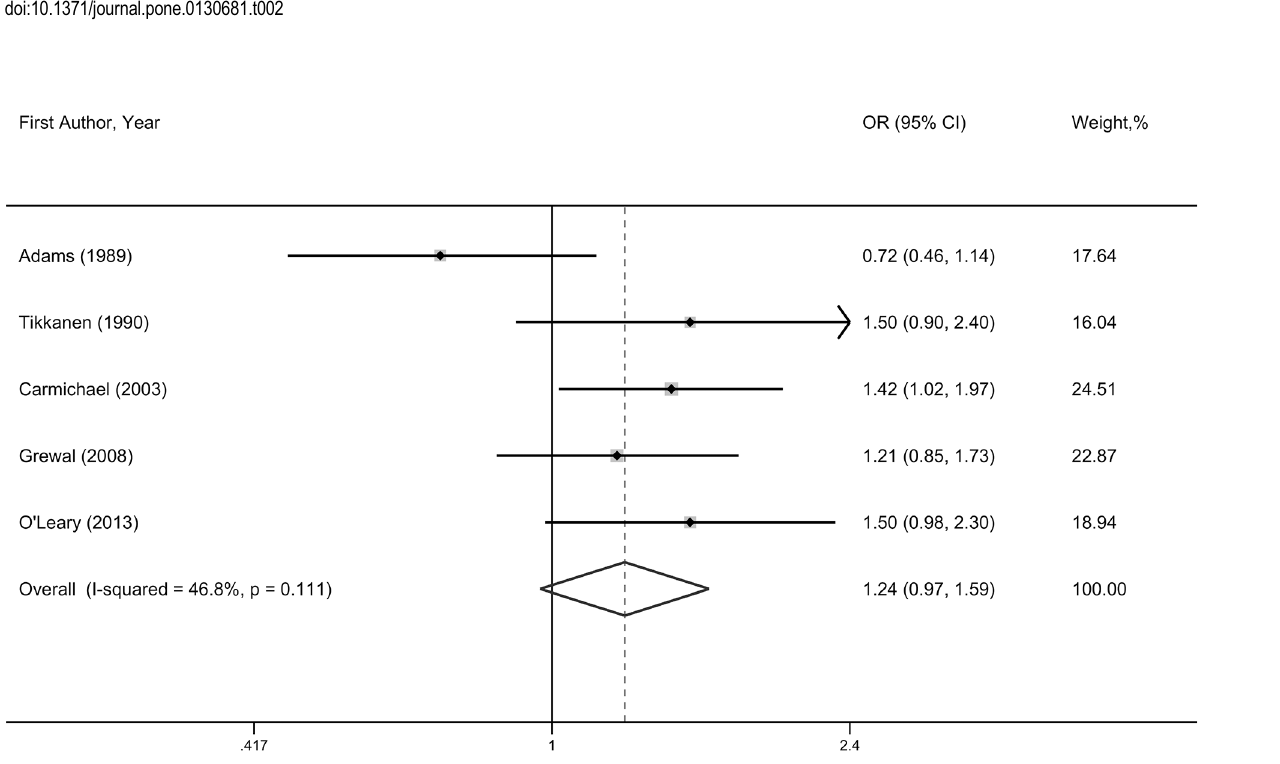
Fig 4. Forest plot of any prenatal alcohol exposure and conotruncal defects